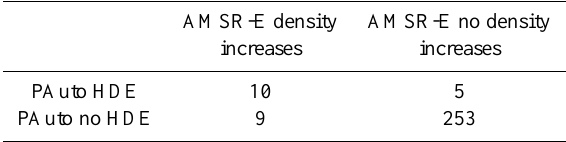
Table 1. Contingency table of hoar disappearance events (detected by near-infrared photography) and polarisation ratio decreases (i.e. increase of snow density near the surface) during the common peri- ods (from 23 November 2009 to 16 February 2010, and from 3